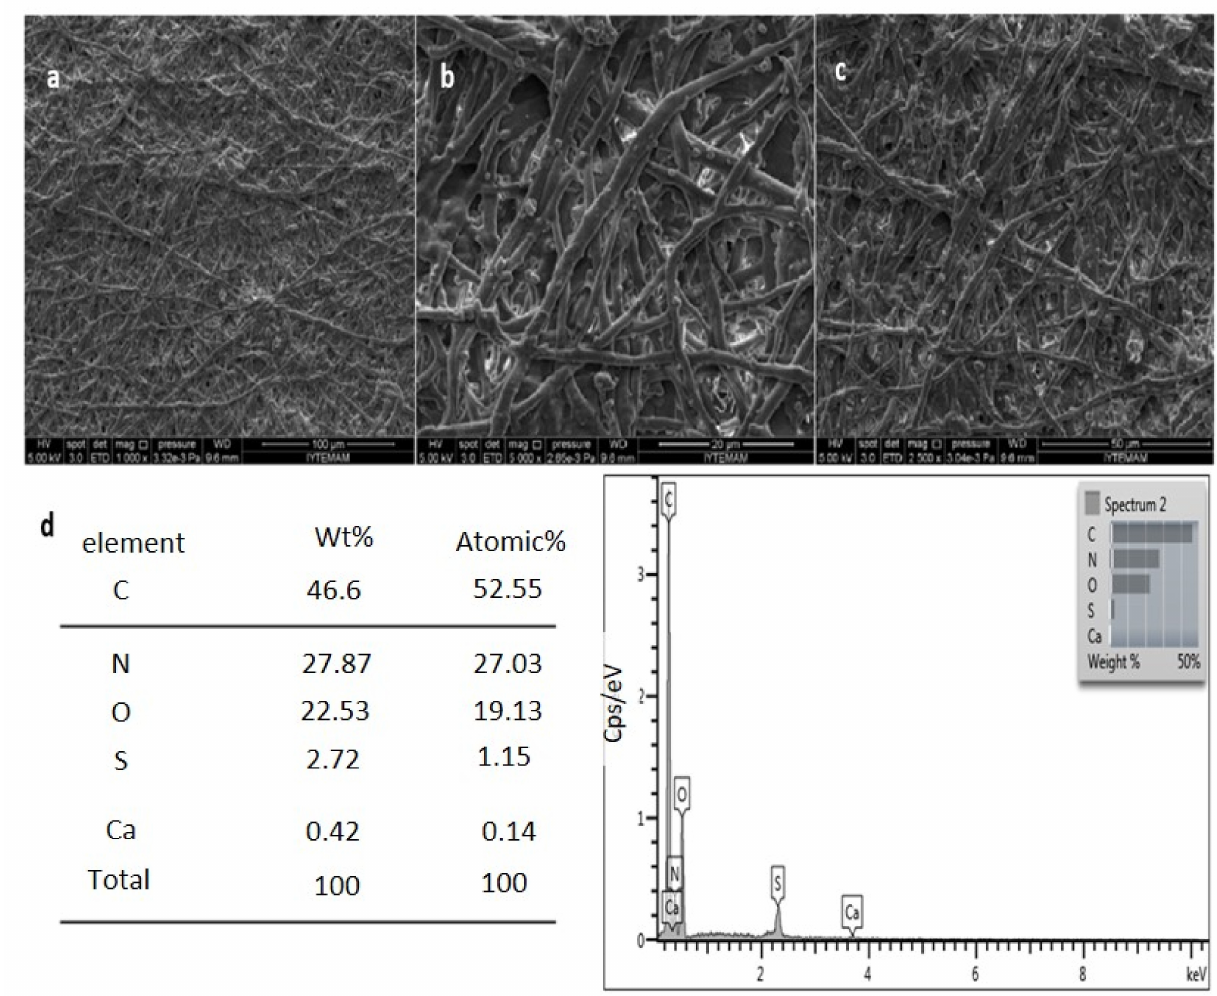
Figure 2. SEM images of the eggshell membrane at ( a ) 1000 × , ( b ) 5000 × , ( c ) 2500 × ; ( d ) EDS analysis of eggshell